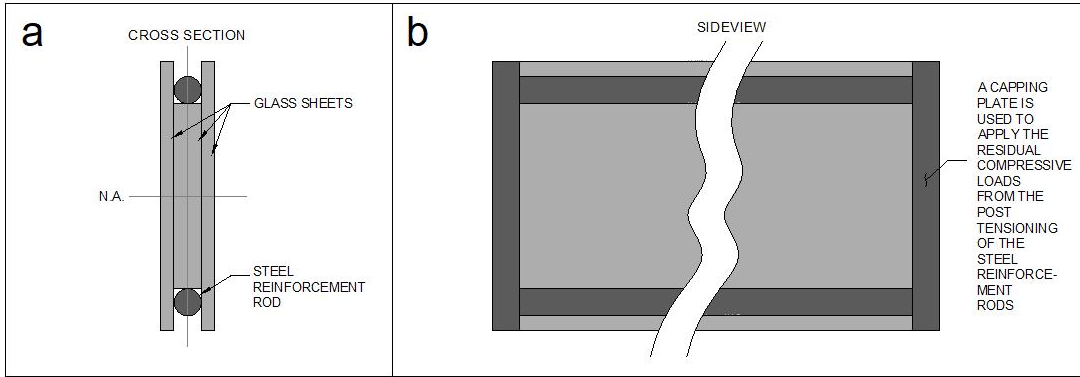
Figure 4. A typical post-tensioned glass composite is shown. These are constructed so that the view through the glass is minimally obstructed while providing increased load capacity to the glass beam through the post-tensioning of the steel